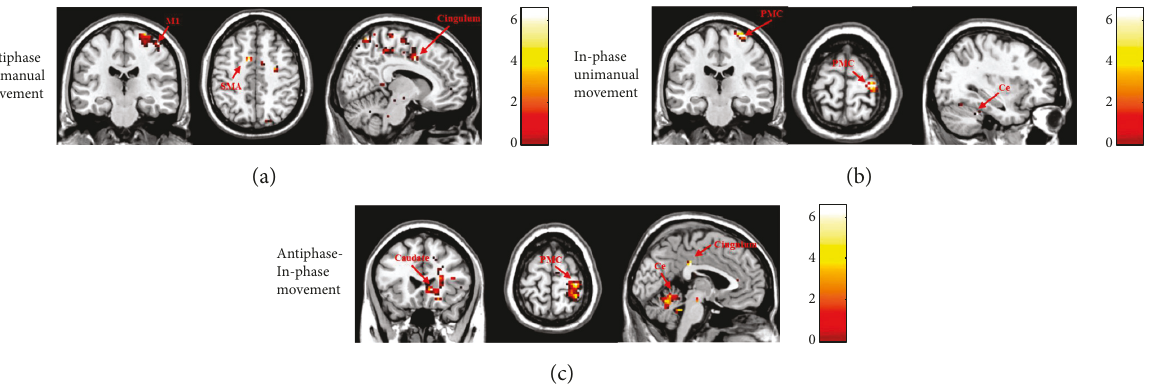
Figure 2: Comparison of brain regions activated during bimanual (antiphase and in-phase) and unimanual (right elbow) movements in the normal subject group. The cingulum area was strongly activated only in antiphase bimanual movements. Results were thresholded at p < 0 001 and noncorrected. (a) Brain areas more activated for antiphase bimanual movements than for unimanual movements in the normal subject group. (b) Brain areas more activated for in-phase bimanual movements than for unimanual movements in the normal subject group. (c) Brain areas more activated for antiphase bimanual movements than for in-phase bimanual movements in the normal subject group. Table 4: Di ff erences of e ff ective connectivity in the cerebellum in the normal subject group during performing antiphase bimanual movements than in performing in-phase bimanual movements. Results were thresholded at P < 0 05 and noncorrected.